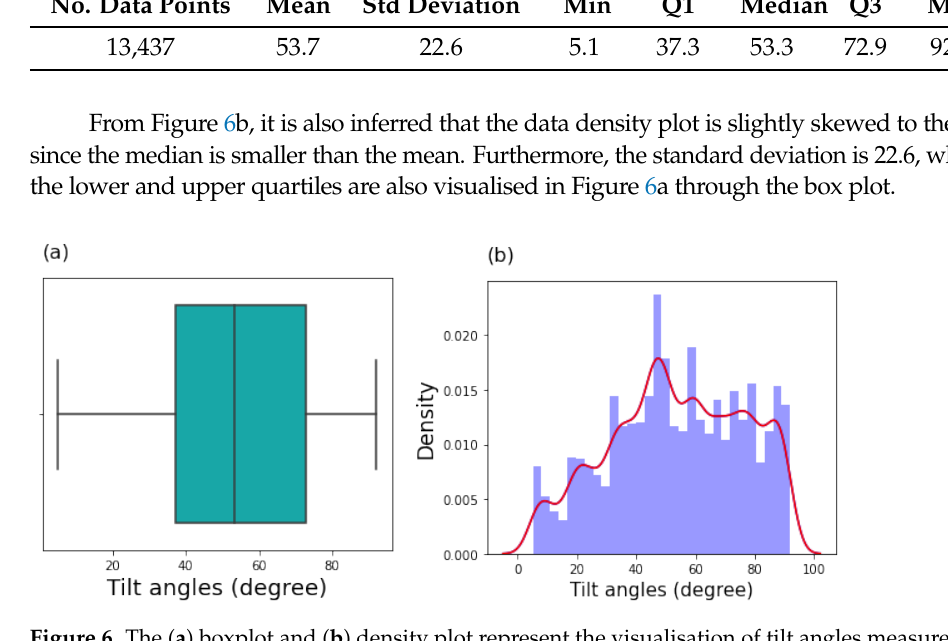
Figure 6. The ( a ) boxplot and ( b ) density plot represent the visualisation of tilt angles measured over three years.